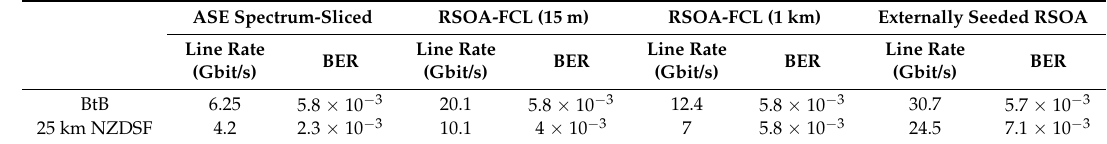
Table 3. Summary of achieved line rate and the respective bit error ratio (BER) for the three transmitter schemes. The results are for a BtB (back-to-back) and after 25 km NZDSF transmission. ASE: amplified spontaneous